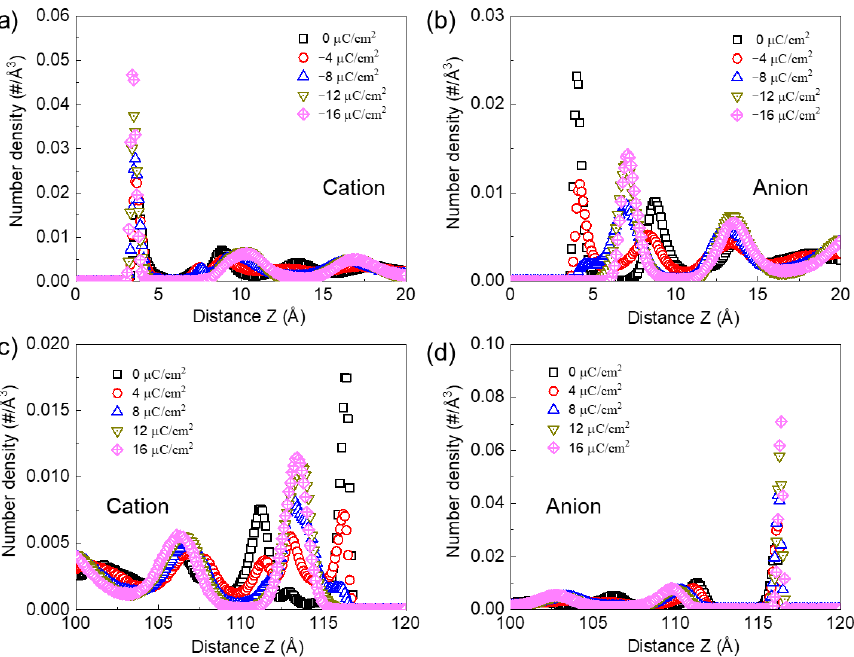
Figure 2. Number density of ( a ) BMI + cation and ( b ) PF 6 − anion nearby the negatively charged MoS 2 electrode. Number density of ( c ) BMI + cation and ( d ) PF 6 − anion nearby the positively charged MoS 2 electrode.